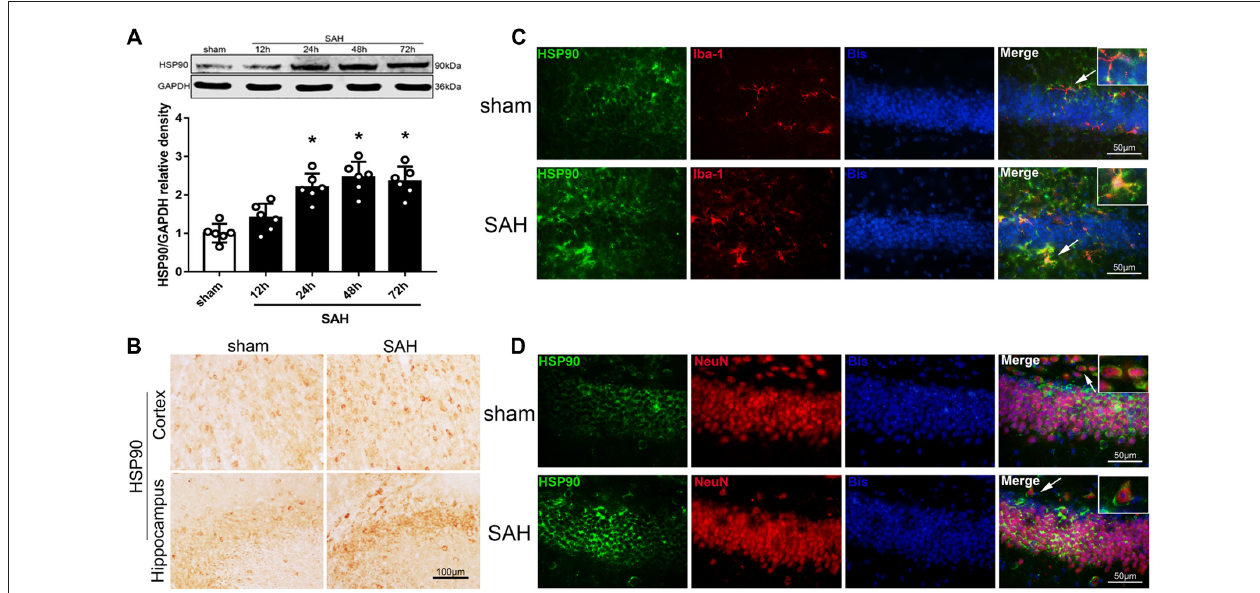
FIGURE 1 | Expression of heat shock protein 90 (HSP90) after subarachnoid hemorrhage (SAH). (A) Representative western blot images and quantitative analyses of the HSP90 time course in the left hemisphere after SAH; n = 6 per group. (B) Immunohistochemistry staining for HSP90 in the left cortex and hippocampus. (C) Double immunofluorescence staining for HSP90 (green) in microglia (Iba-1, red) in the left hippocampus 48 h after surgery. (D) Double immunofluorescence staining for HSP90 (green) in neurons (NeuN, red) in the left hippocampus 48 h after surgery; n = 4 per group. ∗ P < 0.05 vs. sham group. The error bars represent SD. Bis, bisbenzimide; Iba-1, ionized-calcium-binding adaptor molecule-1; NeuN, neuronal nuclear.